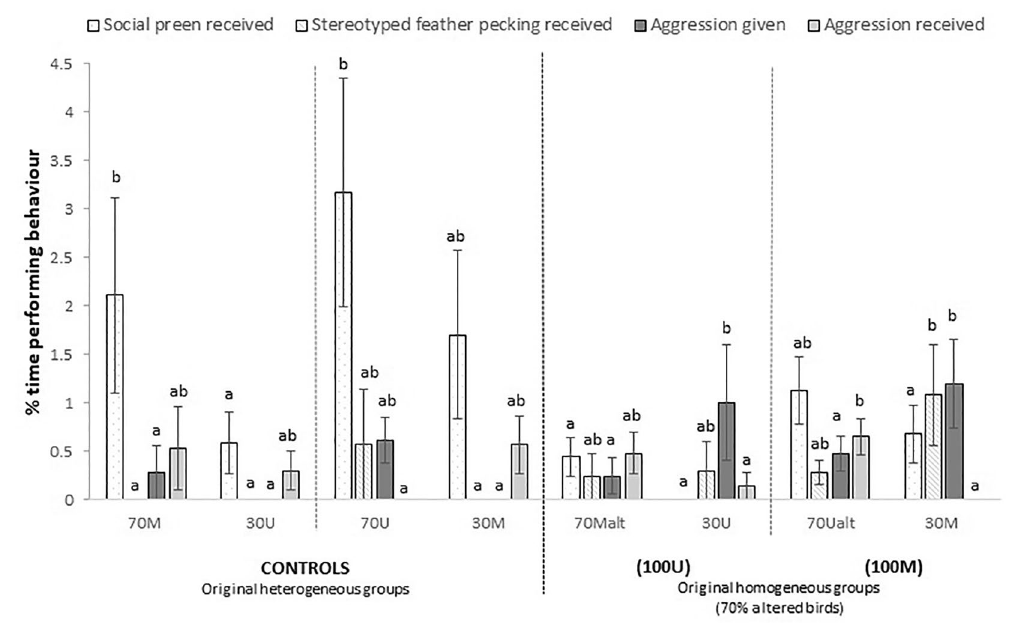
Figure 3. Effects of phenotype alteration to 70% of individuals on the behaviour of hens at 45–46 weeks of age (t3). M: marked; U: unmarked, alt: altered. Bars represent means ± standard errors. Different letters within the same behaviour indicate significant differences among groups at p <